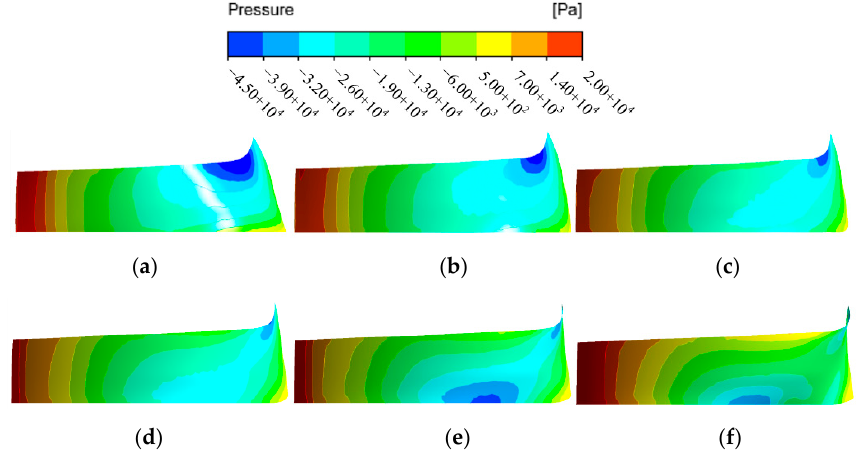
pressure becomes more ununiform when the blade lean angle picks the value of − 10° and − 15°.